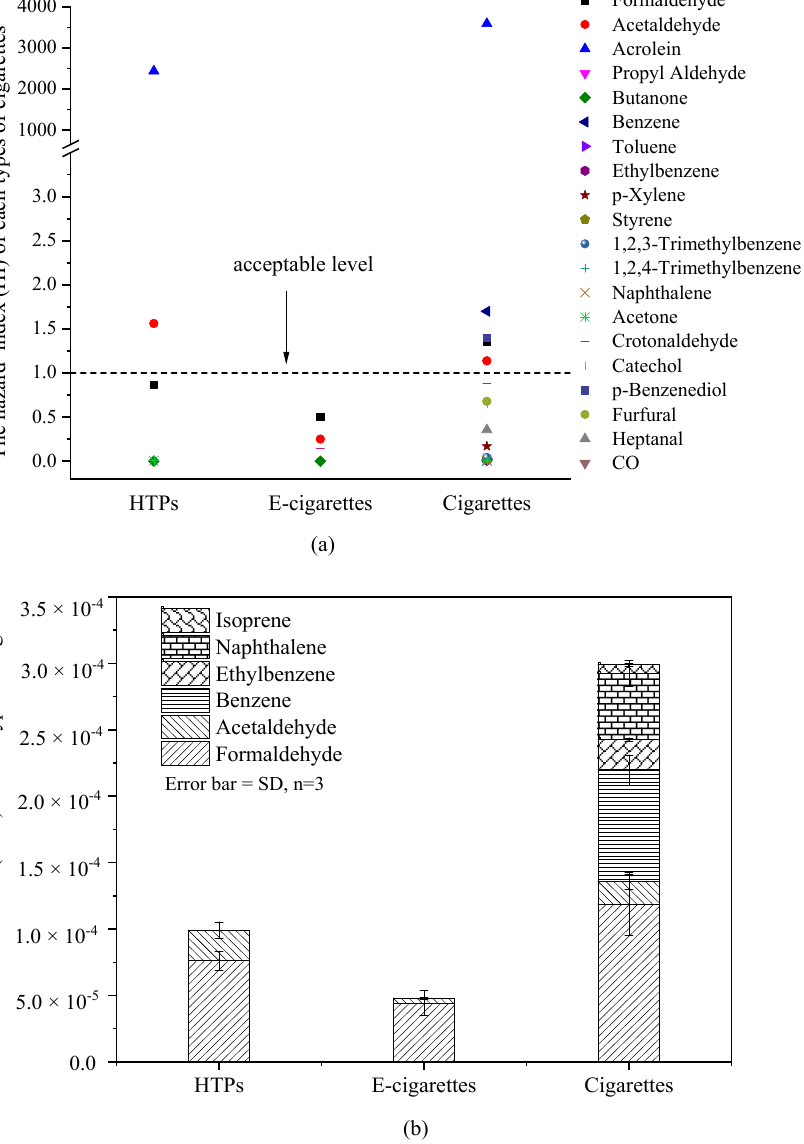
Figure 6. Calculated HI ( a ) and LCR ( b ) of constituents in different types of tobacco products.